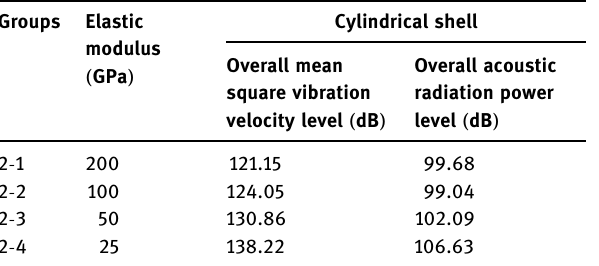
Table 4: The overall vibration level and the overall sound